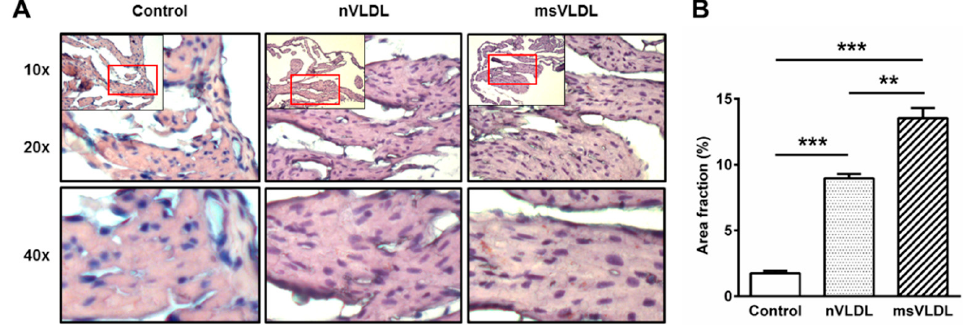
Figure 5. Greater lipid accumulation in atrial tissue of msVLDL mice. ( A ) Representative Oil-Red-O- stained sections of atrial tissues from control ( left ), nVLDL ( middle ), and msVLDL ( right ). Each red rectangle indicates the area to be magnified (20×). Tiny red lipid droplets in controls were few but the number increased in nVLDL and msVLDL atria. Some lipid droplets increased in size in the msVLDL; ( B ) Lipid droplets were significantly increased in the VLDL groups, especially in the msVLDL group (** p < 0.01, *** p < 0.001; n = 3 for each group).